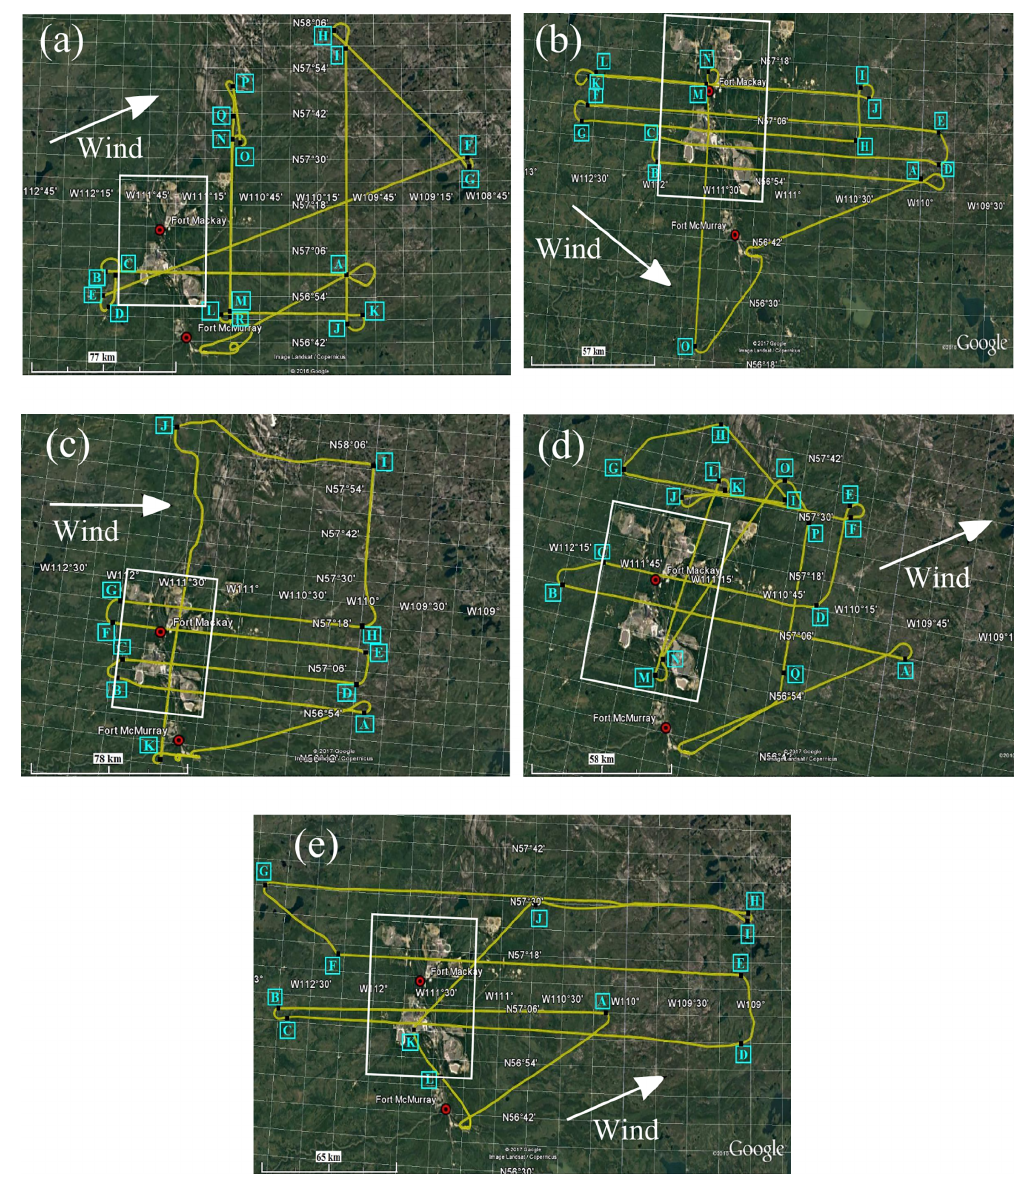
Figure 5. Flight track of the Twin Otter aircraft displayed on Google Earth for (a) 22 August, (b–c) 23 August, (d) 24 August, and (e) 26 August 2013. The direction of wind at the start of each flight is represented by the arrow. The oil sands industry surface operations area is contained within the white box in each